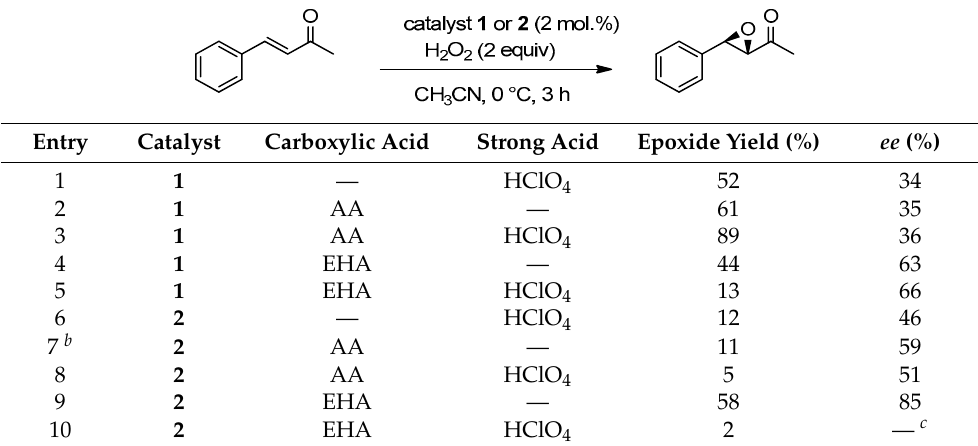
Table 1. The effect of HClO 4 on the asymmetric epoxidation of benzylideneacetone with H 2 O 2 in the presence of complexes 1 and 2 a .